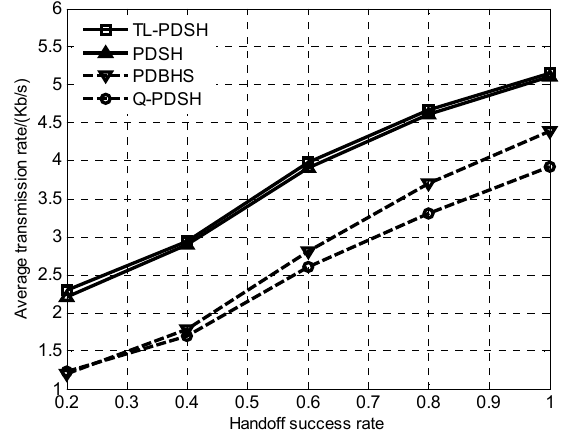
Figure 4. Transmission rate versus handoff success rate.